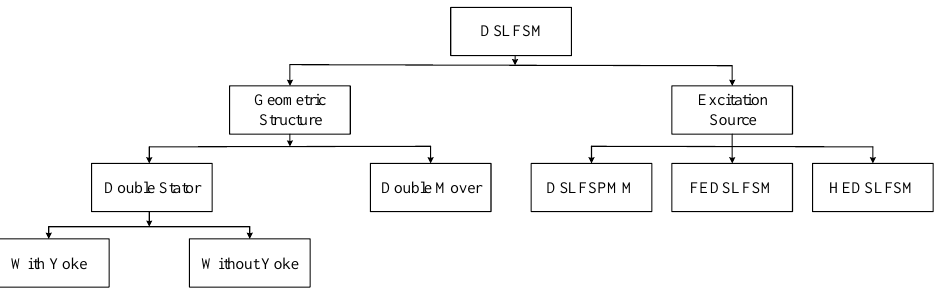
Figure 1. Broad classification of DSLFSMs.